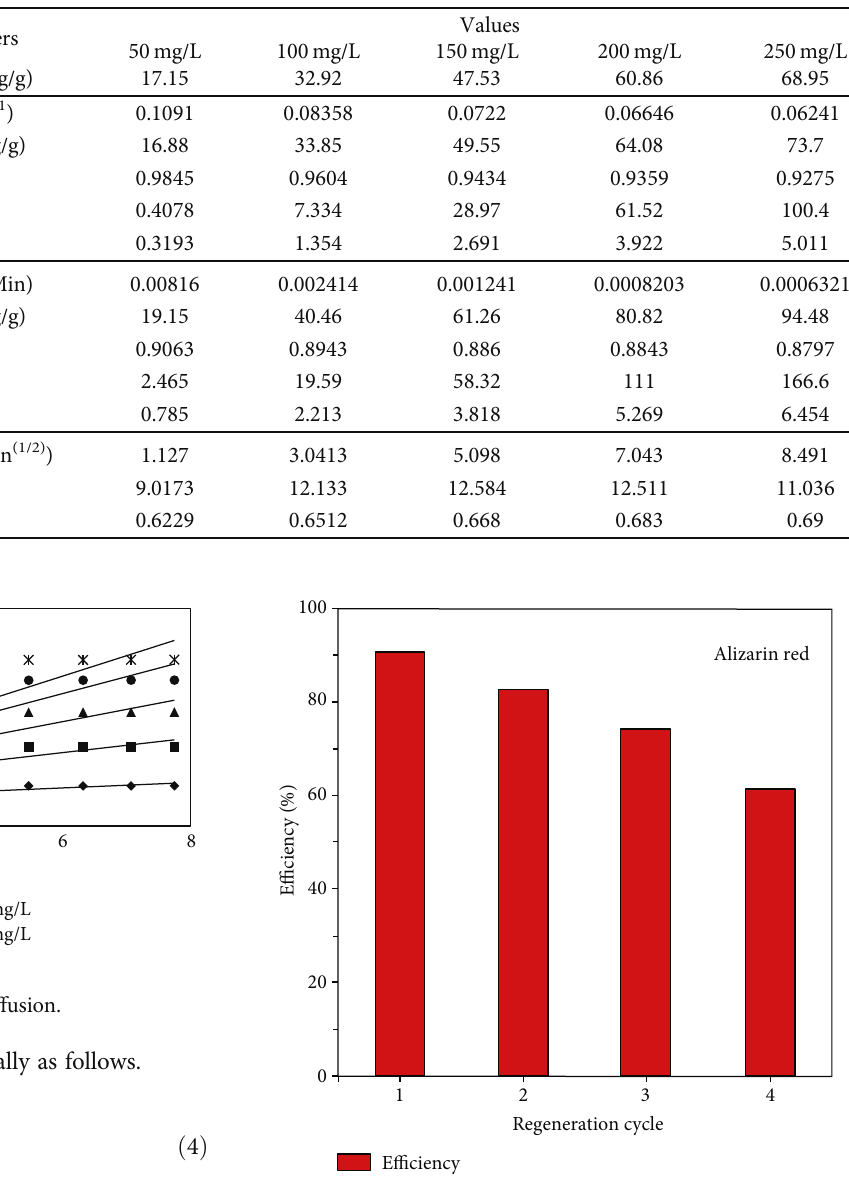
Table 5: Rate constants and other parameters for the adsorption